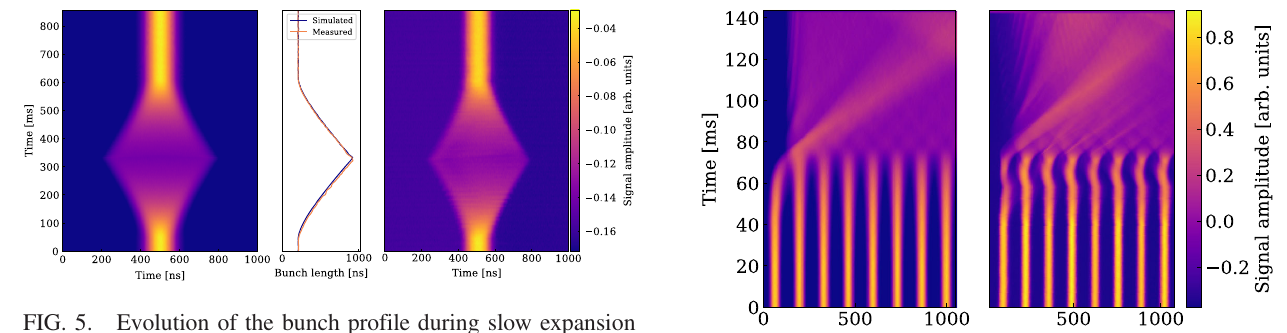
_ ϕ _ ϕ ≈ 0 . 01 . The = b f FIG. 6. Beam reflecting off a potential barrier, shown over half a PS turn. The amplitude of the h ¼ 16 system was lowered and then subsequently turned off at 70 ms, and the amplitude of the barrier bucket rf system was increased to reach the maximum at the same time. The transverse beam splitting was disabled during these measurements. Simulated (left) and measured (right) profiles are